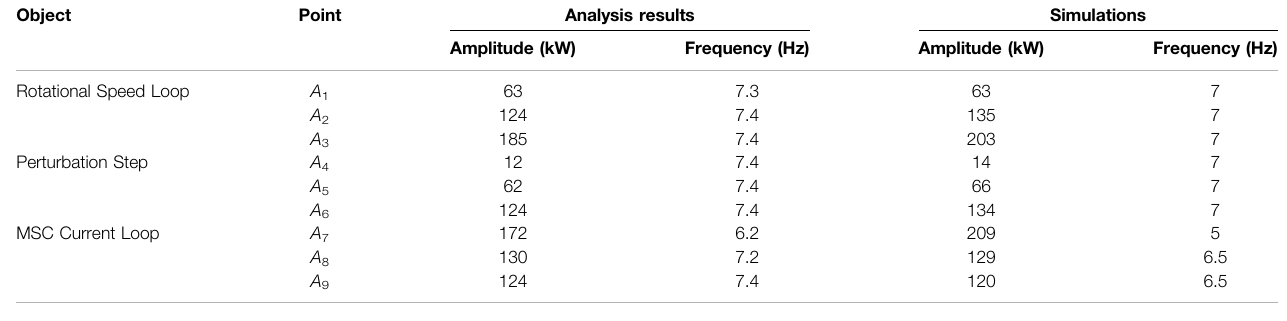
TABLE 3 | Quantitative comparison of MSC controller parameters. Object